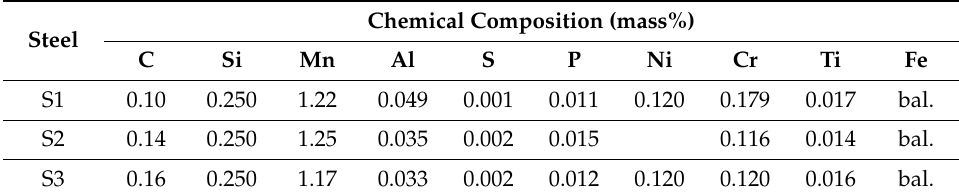
Table 1. Chemical composition of the hypo-peritectic steel